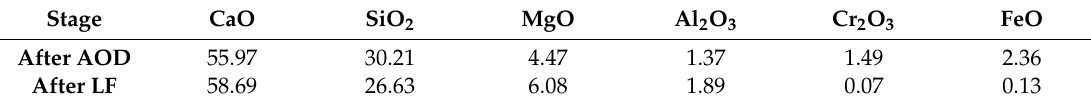
Table 2. Chemical composition of 304L slag at different stages (mass fraction